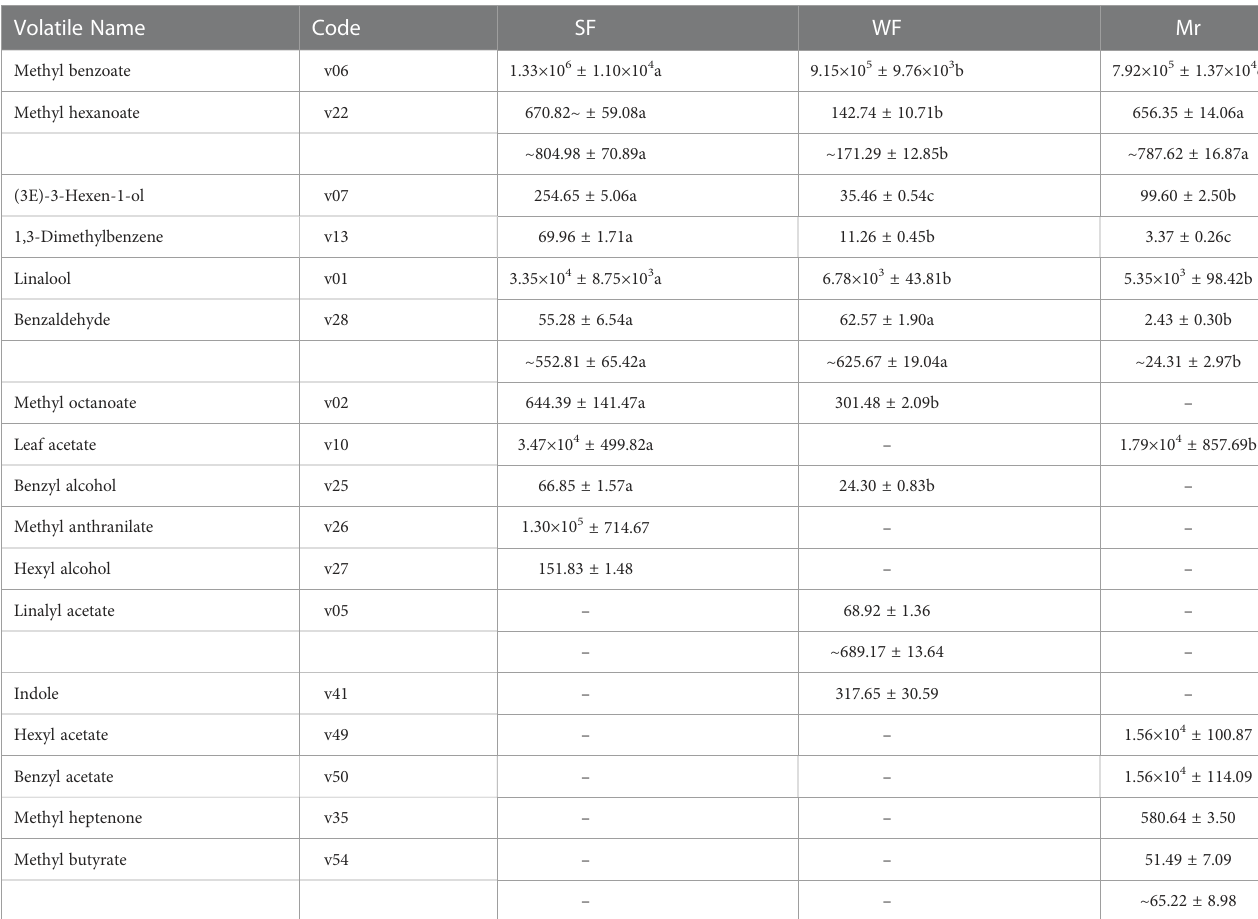
TABLE 2 Odor activity values of key fl oral